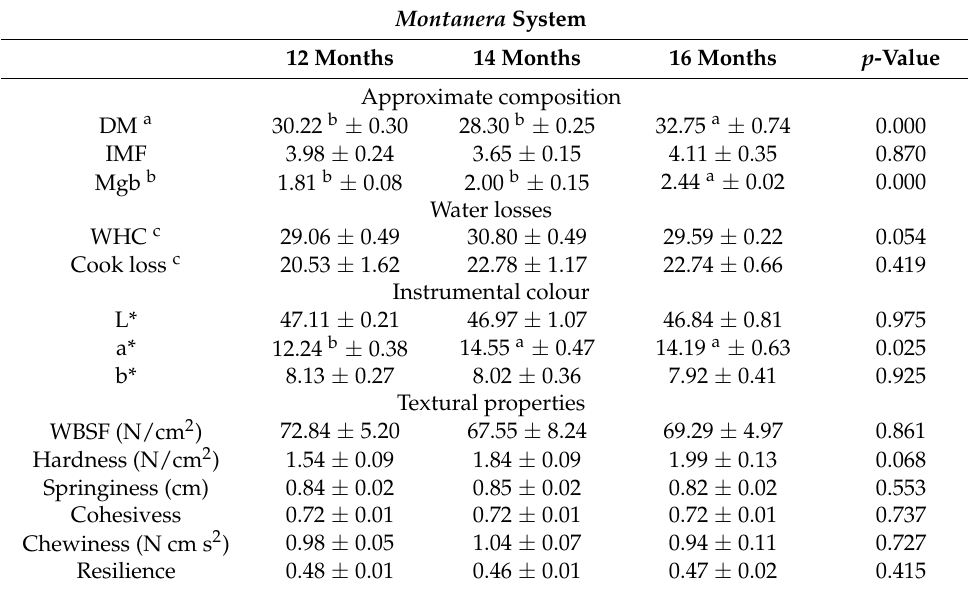
Table 5. Quality traits measured in fresh loins (m. Longissimus thoracis ) from Iberian × Duroc crossed animals reared under the Montanera system according to slaughter